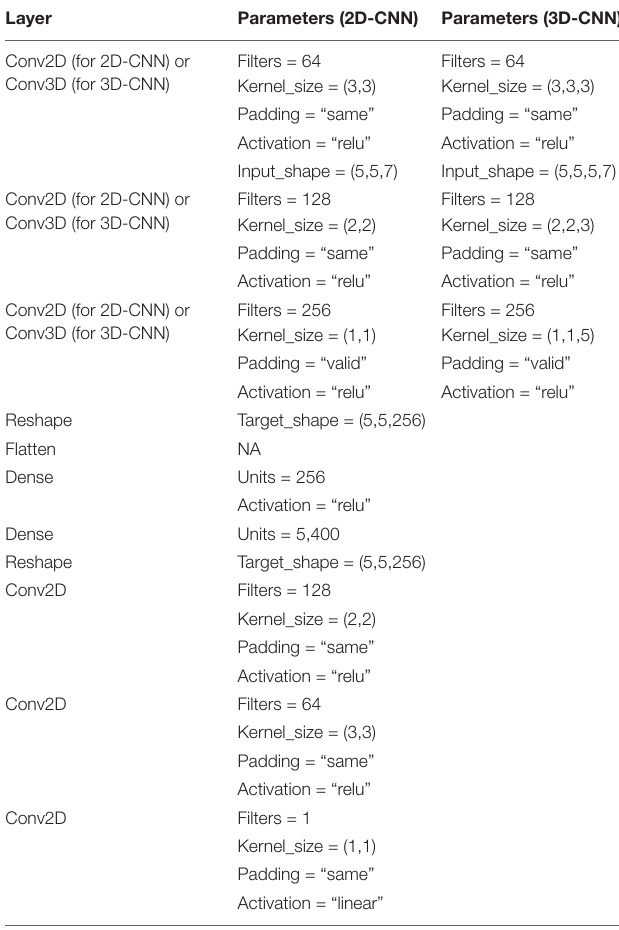
TABLE 3 | Parameters for